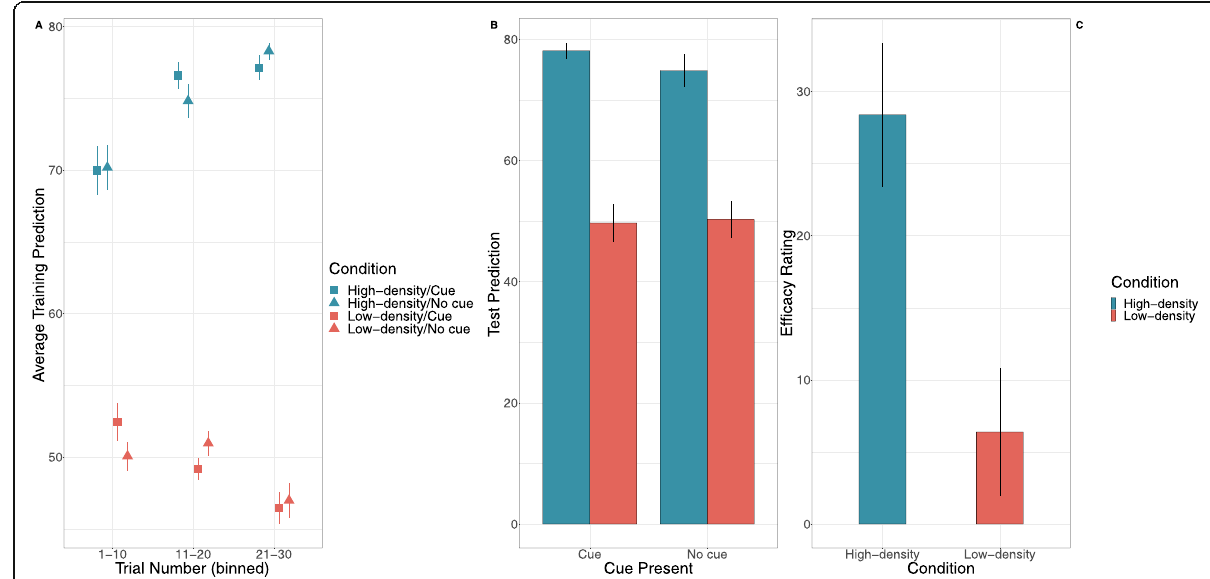
Fig. 7 Results from Experiment 3 for a training predictions as a function of outcome density condition, cue presence, and trial as well as b predictions of students ’ average performance as a function of outcome density condition and c efficacy ratings as a function of outcome density condition. Error bars represent + 1 standard error of the